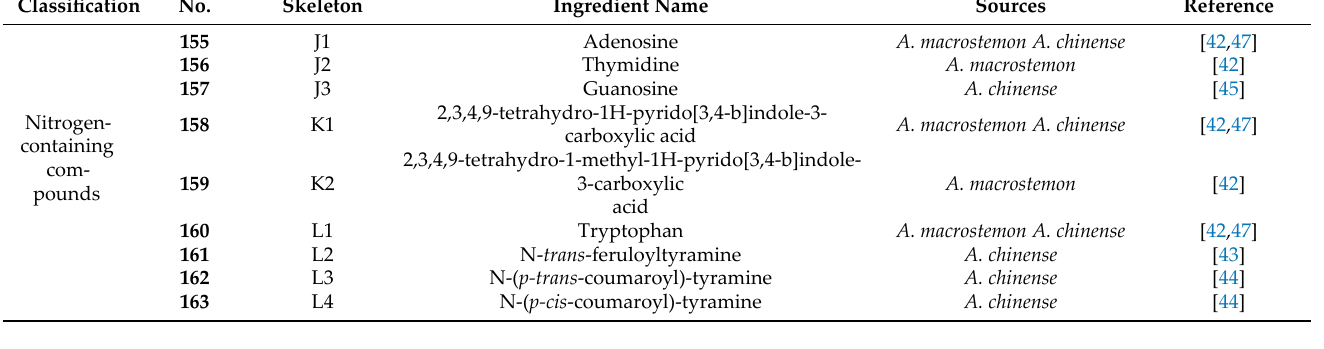
Table 6. List of nitrogen‑containing compounds previously identified from AMB.